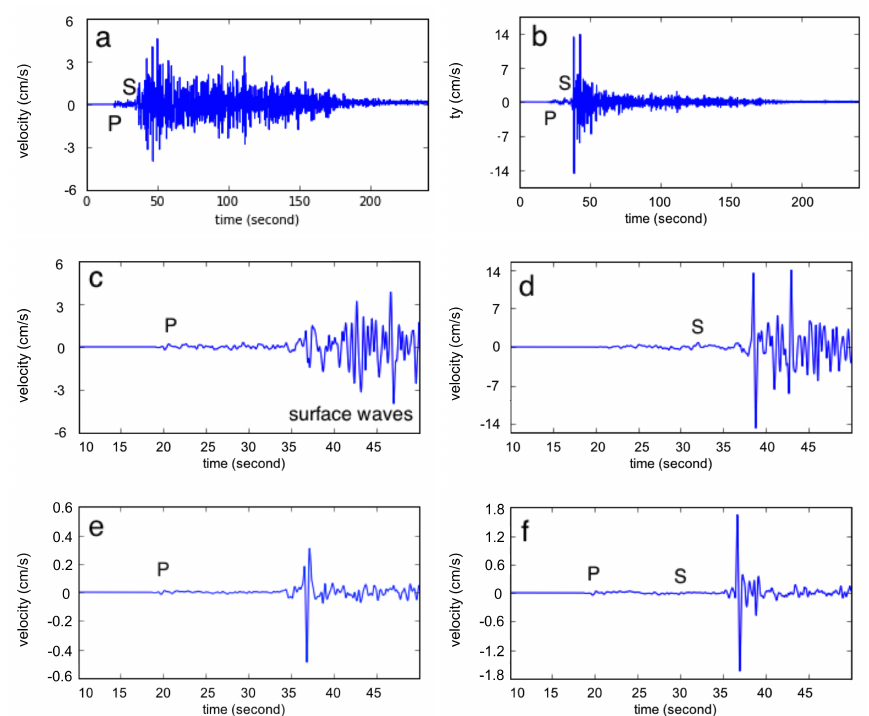
Figure 10. Seismograms at stations S2169, both for vertical ( a ) and horizontal ( b ) components, showing P-, S- and surface waves generated from the crustal fault scenario. Figure ( c , d ): the same seismograms at time 10–50 second, showing the arrival of direct S followed by Rayleigh surface waves at about 37 s. Similar to ( c , d ), ( e , f ) are seismograms recorded at bedrock